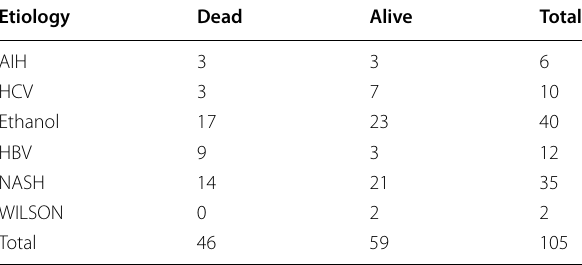
Table 1 Etiology of chronic liver disease among study